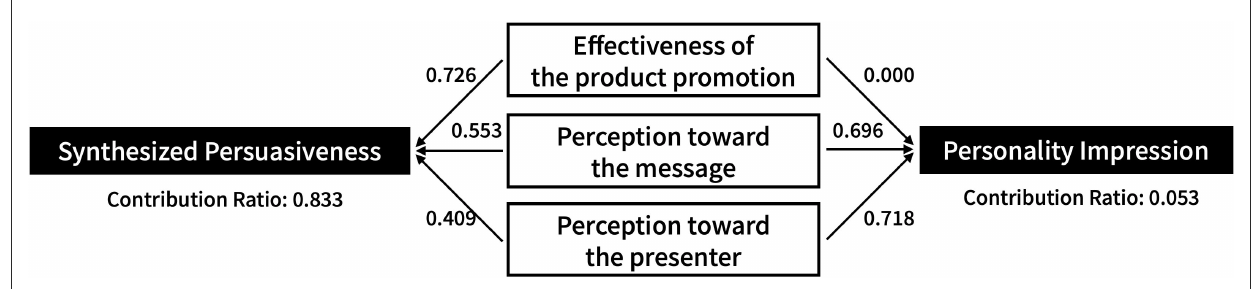
FIGURE3 Results of principal component analysis on the synthesized persuasiveness index.